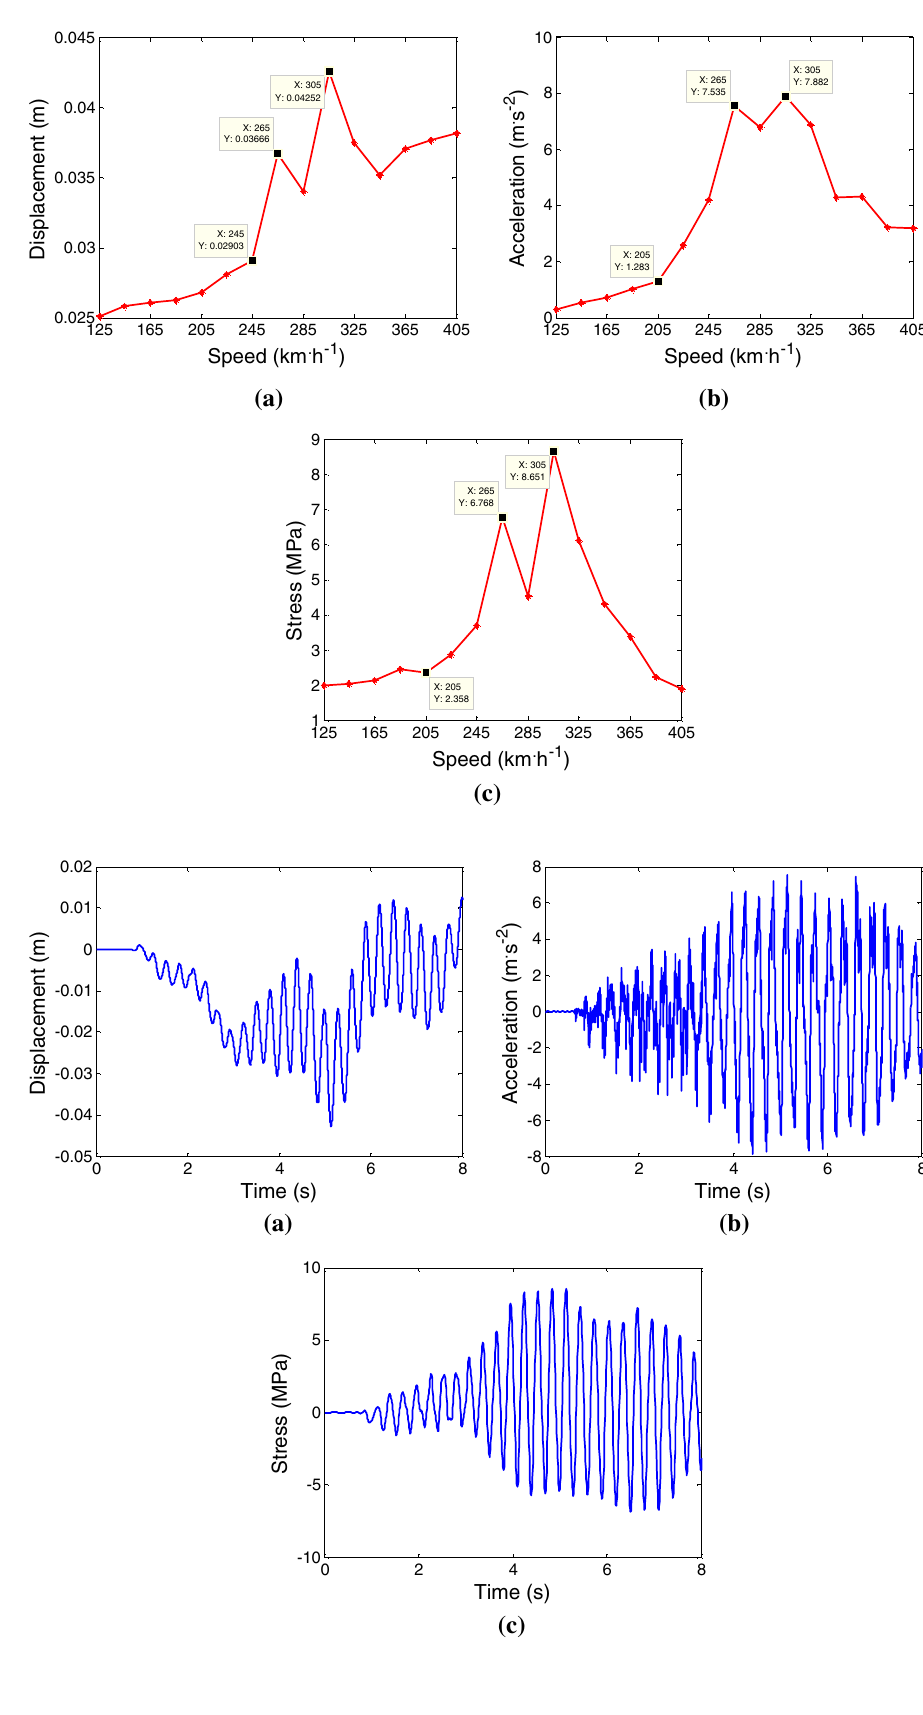
Fig. 9 Maximum responses of the cantilever deck at the center of the fourth span of the composite box girder bridge: a deflection at the outer rail; b acceleration at the outer rail; and c stress at the root of the cantilever deck